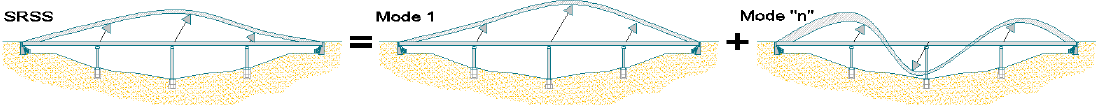
Figure 5. Flowchart of IMPA β procedure. 3. Case Studies 3.1. Bridges The two case studies selected were both derived from a straight bridge with four equal spans (span length of 50 m) and total length equal to 200 m (Figure 6), already used by many authors in previous comparison works since the 1990s [32]. In both cases, the deck consisted of 14 m wide pre- cast concrete box girders supported by piers consisting of a circular cross-section with a 2.5 m diameter; the pier heights were variable and differentiate the two case studies (Figure 7). The deck was supported by two abutments through elastomeric bearings (movement in the longitudinal direction was allowed at the abutments, but transverse displacements were restrained) and on the concrete pier-heads through bearings locked in the transverse direction. The concrete class used was C20/25 (characteristic compressive cylindric strength f ck = 20 MPa), while B450C steel (characteristic yield strength f yk = 450 MPa) reinforcement was used throughout the structure. Both bridges were designed according to Eurocode 8, using a design peak ground acceleration of 0.35 g and a behavior IMPA